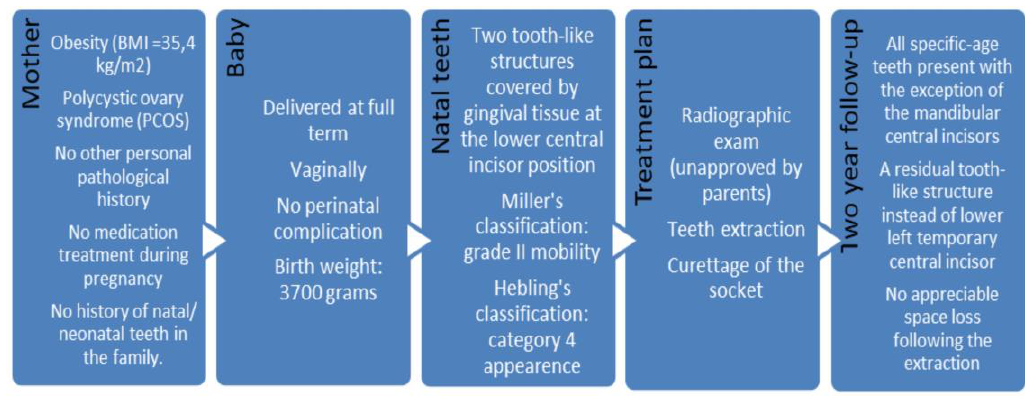
Table 1. Summary of the case report.